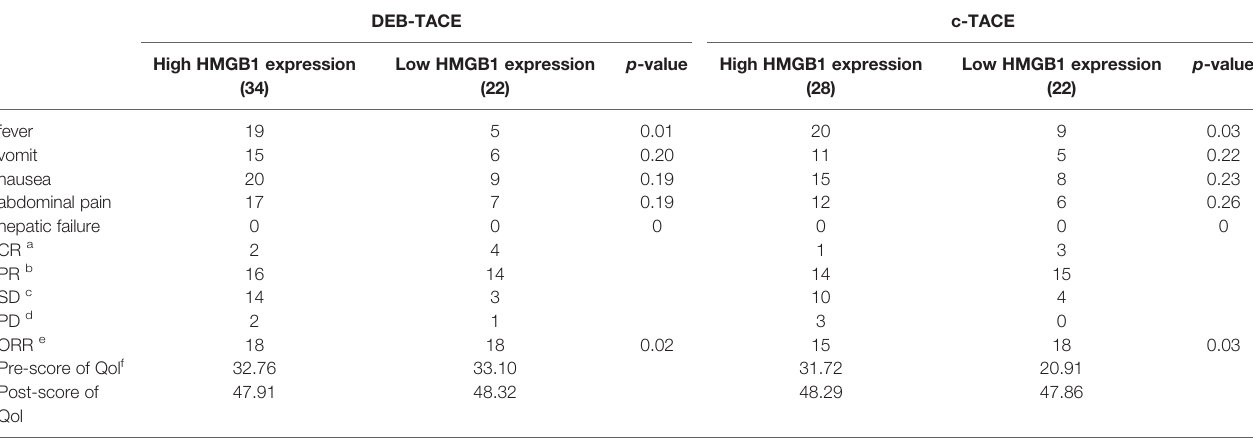
TABLE 4 | Expression of HMGB1 group, common adverse reactions treatment outcomes.